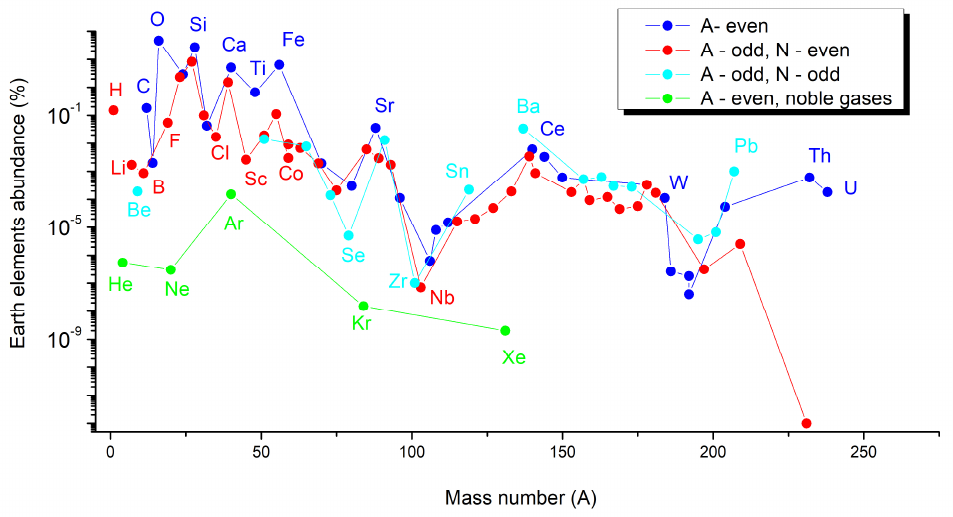
Figure 7. Earth-abundant elements as a function of their mass number (A) [49].